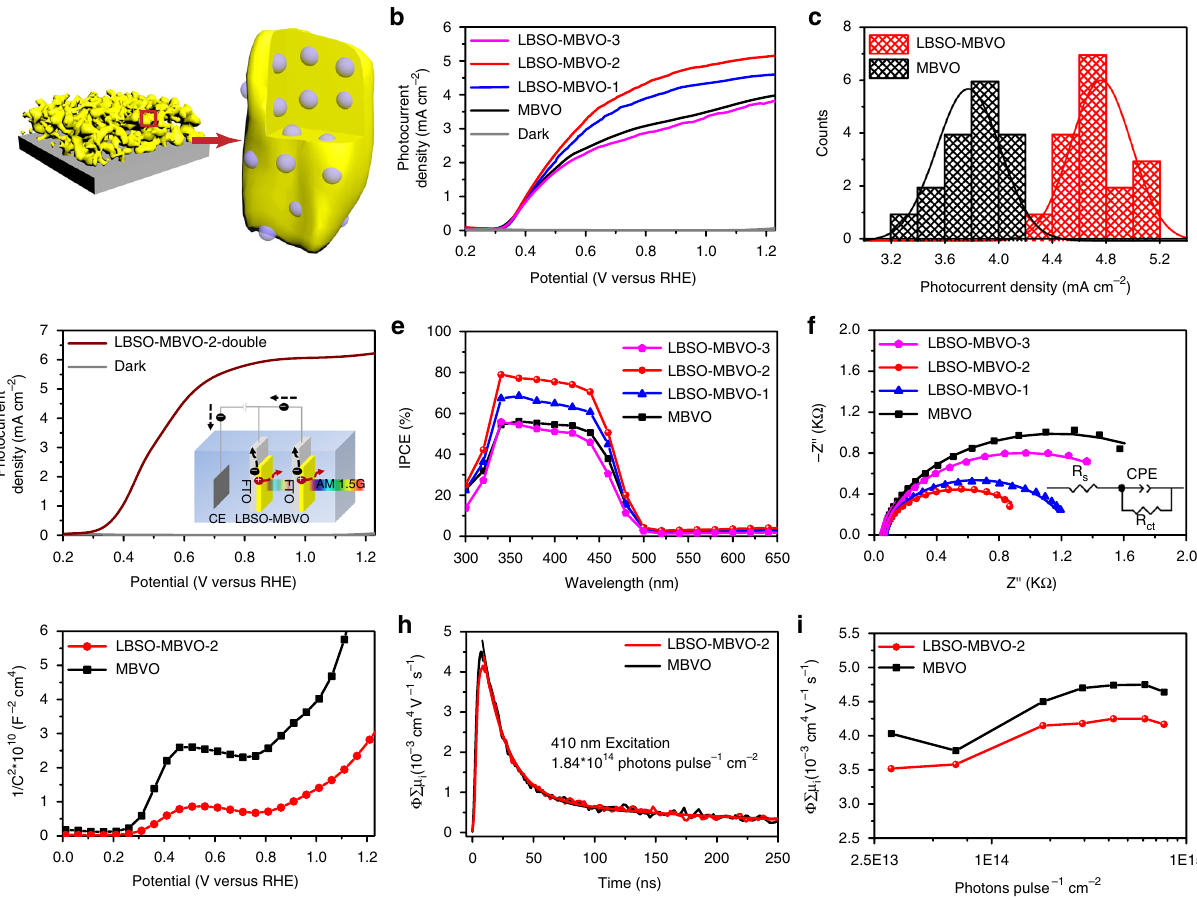
Fig. 3 Performance of MBVO and LBSO-MBVO fi lms. a Schematic representation of pulsed laser generated nanocrystals embedded MBVO fi lms. b J – V curves of different LBSO-MBVO photoanodes under AM 1.5G irradiation. c Photocurrent density distribution of MBVO and LBSO-MBVO fi lms at 1.23 V RHE . d J – V curves of the LBSO-MBVO-2 dual photoanodes under AM 1.5G irradiation. Insert: schematic of LBSO-MBVO-2 photoanodes with dual con fi guration. e IPCE curves at 1.23 V RHE and f EIS curves of different LBSO-MBVO photoanodes. g MS curves of MBVO and LBSO-MBVO-2 fi lms. h Time-resolved microwave conductance signals recorded for MBVO and LBSO-MBVO-2 fi lms using a 410 nm laser pulse with a photon fl ux of 1.84 × 10 14 photons pulse − 1 cm − 2 . i Maximum TRMC signals as a function of incident photons per laser pulse for MBVO and LBSO-MBVO-2 fi